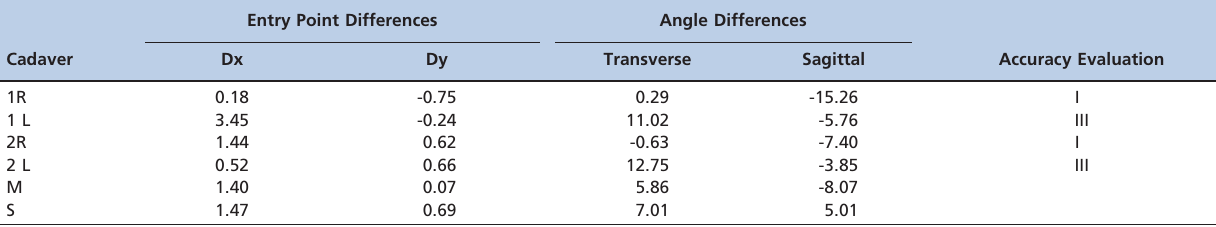
Table 1 - Comparison of Planned vs . Inserted Screws (Stage